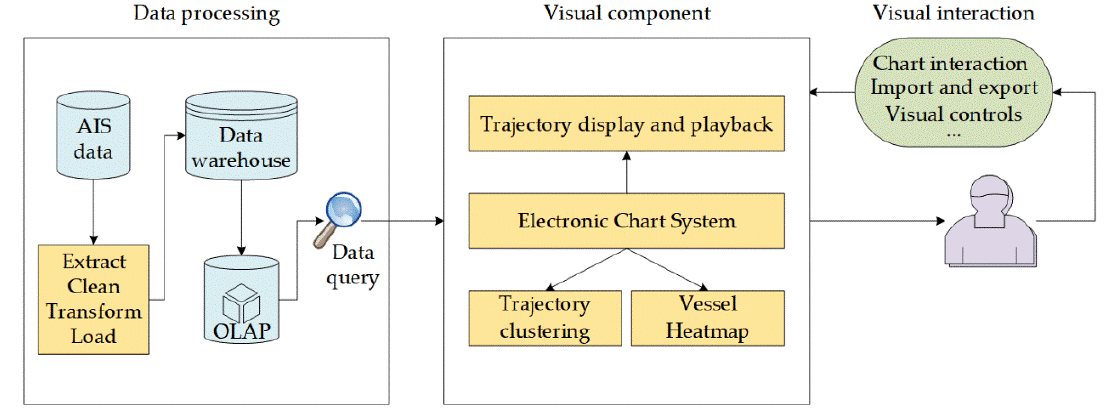
Figure 1. Overview of system workflow.